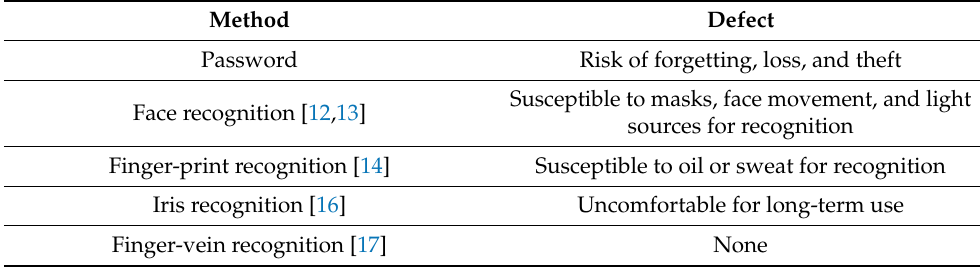
Table 2. The comparison of biometrics’ identification method.